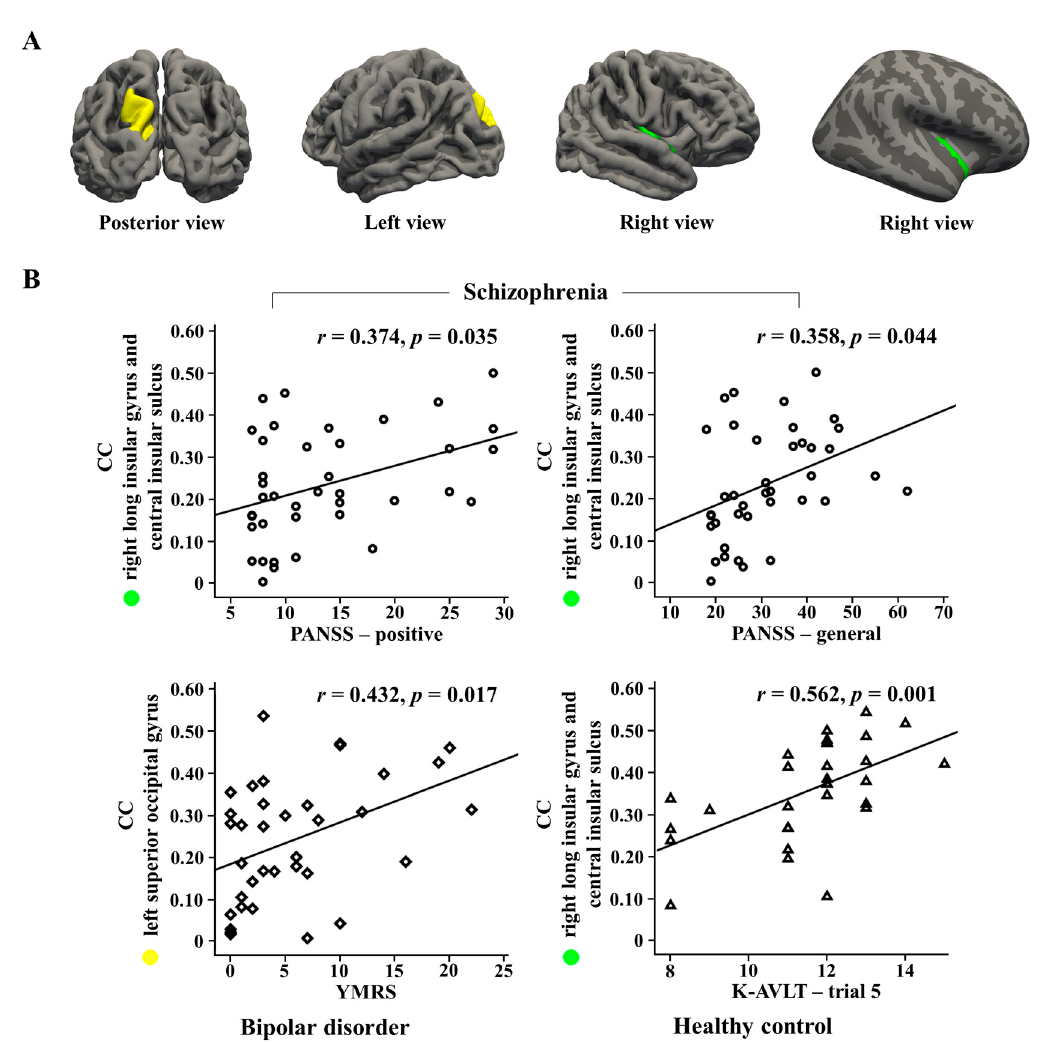
Figure 2. ( A ) Brain regions of right long insular gyrus and central insular sulcus, and left superior occipital gyrus ( B ) Correlations of nodal clustering coefficients (CCs) in two regions with psychological measures in each group. PANSS: positive and negative syndrome scale; YMRS: Young Mania Rating Scale; K-AVLT: Korean Auditory Verbal Learning Test.